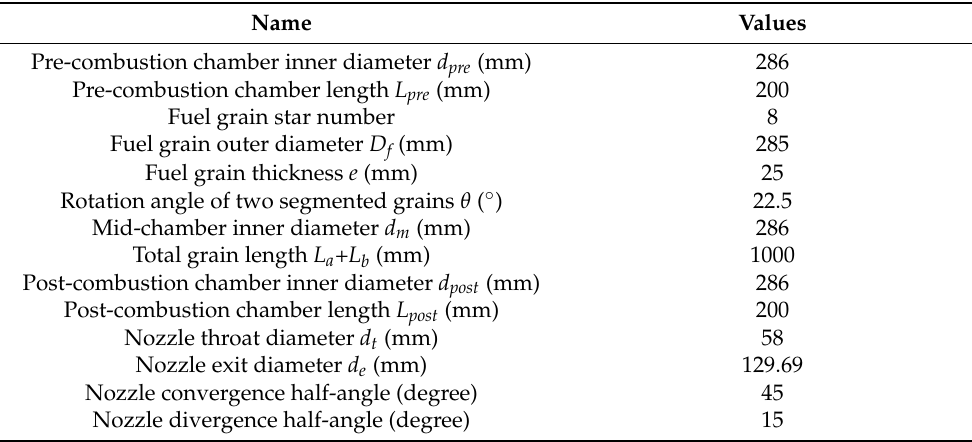
Figure 3. The rotation angle of the two star-segmented grains. Table 1. Main structure parameters of the full-scale hybrid rocket motor.